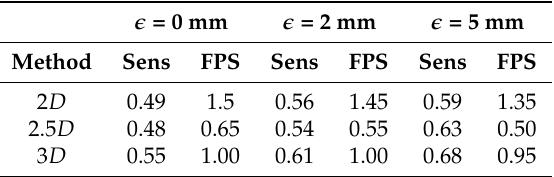
Table 1. Per embolus sensitivity and false positives per scan of the three proposed methods at the three tolerance levels. The cutoff threshold was set at